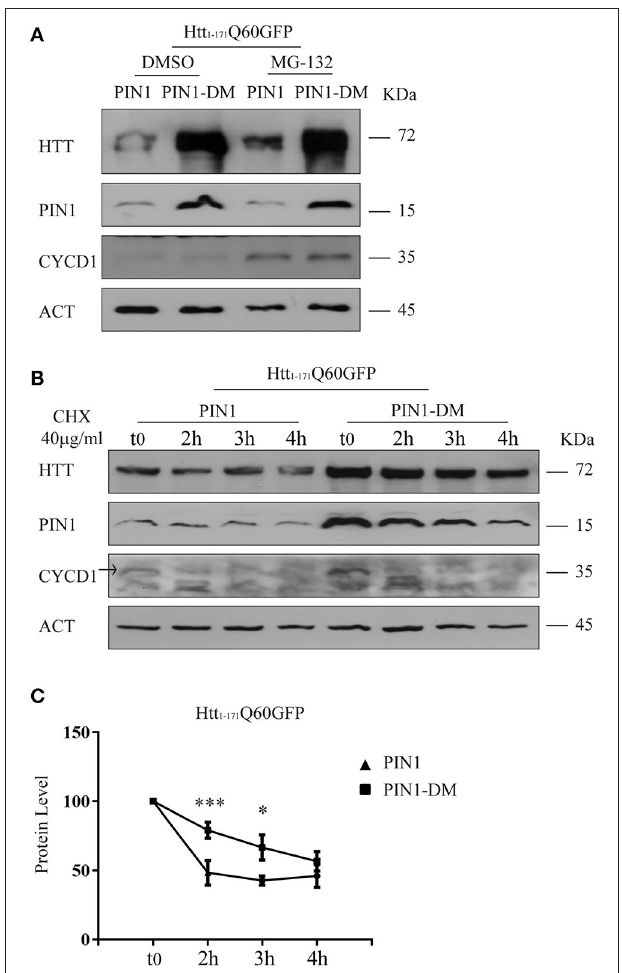
FIGURE 5 | PIN1 regulates mHTT half-life. HEK293 cells were co-transfected with htt 1 – 171 Q60GFP and HA-PIN1 or HA-PIN1DM. Cells were harvested for analysis at indicated time points. (A) Representative western blot showing htt 1 – 171 Q60GFP upon MG-132 treatment (10 µ M for 6h) in the presence of PIN1 as compared to PIN1DM. Western blot also shows PIN1, CYCLIN-D1, and β -ACTIN as loading control. Cells were treated 24h after transfection. (B) Representative western blot showing htt 1 – 171 Q60GFP levels upon treatment with CHX (40 µ g/ml), at different time points, in the presence of PIN1 as compared to PIN1DM. Westerm Blot also shows PIN1, CYCLIN-D1, and β -ACTIN as loading control. CHX treatment started 6h after transfection. (C) Relative htt 1 – 171 Q60AGFP protein level based on western blots quantification as shown in (B) . Data are the mean ± SEM from 6 independent experiments using 2 different batches of cells. * P < 0.05, *** P < 0.001. Asterisk indicates the statistically significant difference in